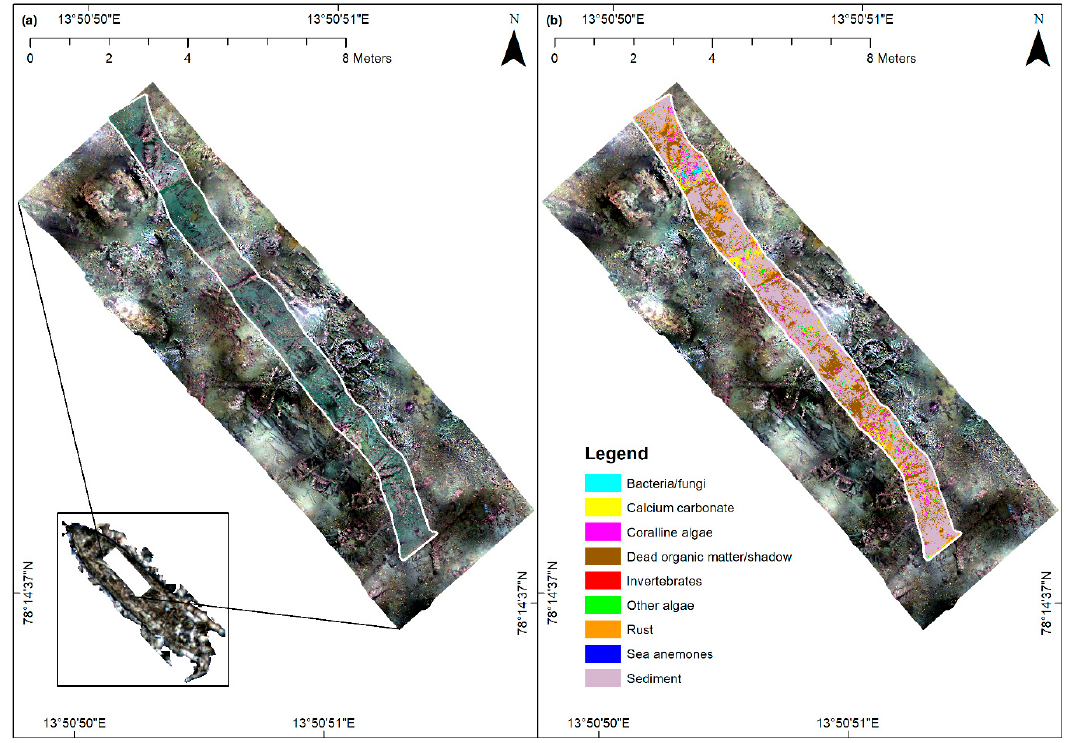
Figure 11. Underwater hyperspectral imaging (UHI) results from the Figaro wreck site. Panel ( a ) shows an RGB representation (R: 660 nm, G: 550 nm, B: 510 nm) of the internal average relative reflectance (IARR)-converted and georeferenced UHI transect (14.65 m 2 areal coverage) draped over a contrast-enhanced subset of the Figaro orthophoto, whereas panel ( b ) shows the corresponding support vector machine (SVM) classification results. The figure was generated in ArcMap (v. 10.6; Esri Inc., Redlands, USA; http://desktop.arcgis.com/en/arcmap/). Projection: UTM 33, Datum: WGS 1984.